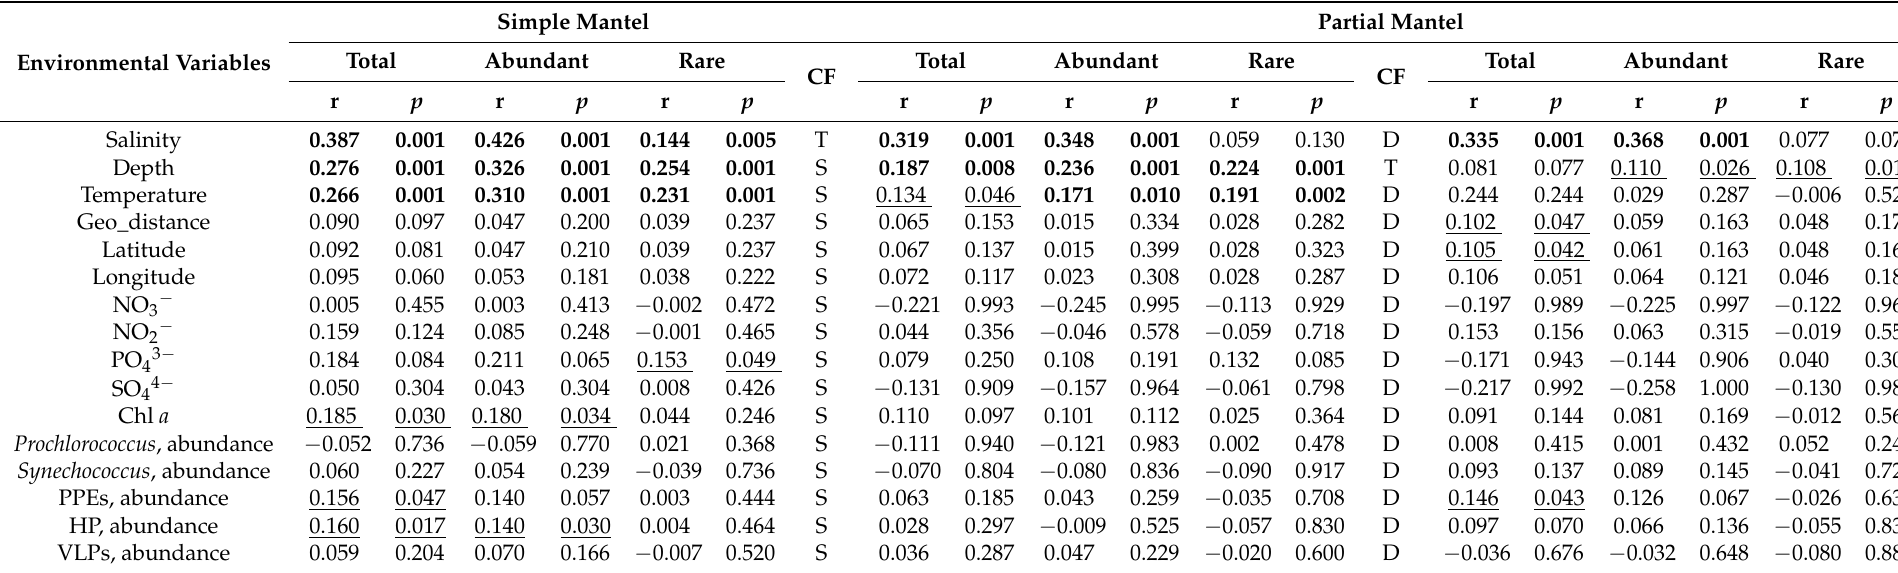
Table 3. Simple and partial Mantel tests for the correlations between environmental factors and protistan community composition. When the correlation is significant both r- and p -values are underlined ( p < 0.05) or in bold ( p < 0.01). (CF: Control for; Geo_distance, geographic distance; HP: Heterotrophic prokaryotes; PPEs, pigmented pico-sized eukaryotes; VLPs, viral